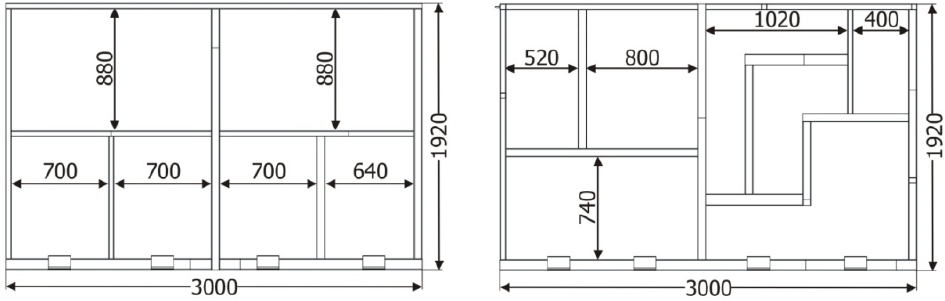
Figure 4. Geometric configuration of the sides of the tubular validation structure. Unit: mm.